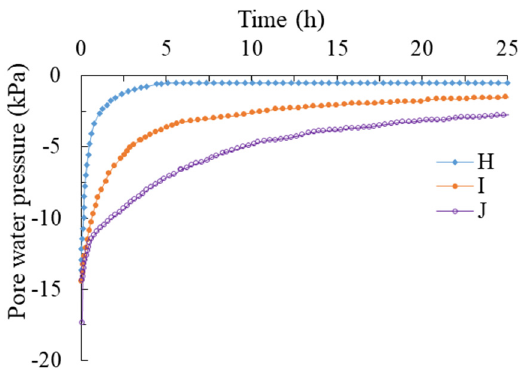
Figure 6. Time series of pore water pressure at three monitoring points.